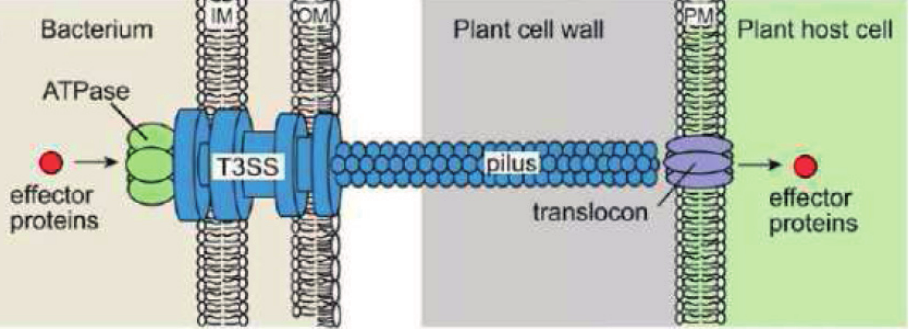
Figure 1. Schematic representation of the T3SS from plant pathogenic bacteria [39] (modified from [39], with permission from American Society of Plant